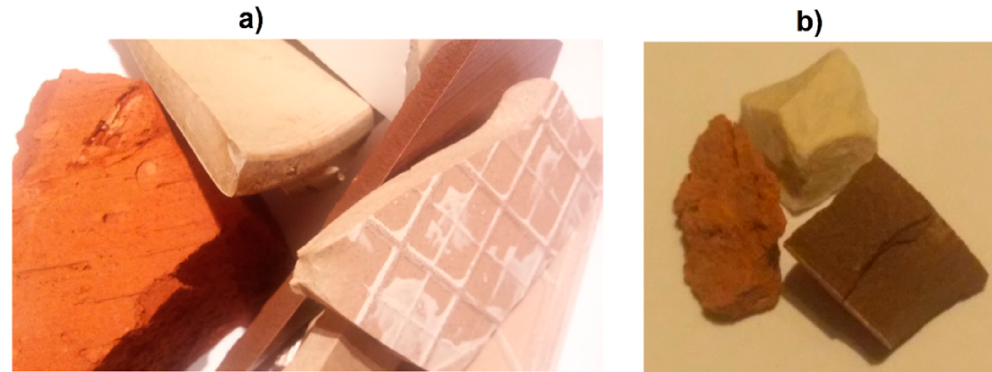
Figure 5. Close-up of the surface of the ceramic: ( a ) in the form of waste, ( b ) a form representative of the shape of aggregate grains.